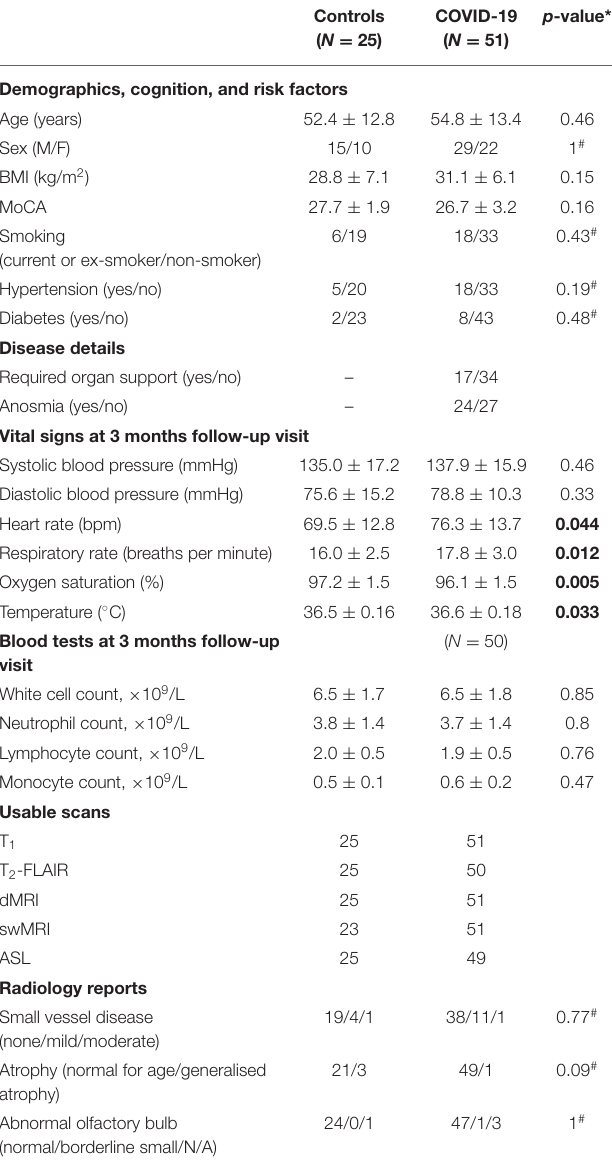
TABLE 2 | Demographics, vital signs, and blood test at follow-up (3 months visit), disease details, usable brain MRI scans, and radiology reports details of patients and control participants in the C-MORE study.